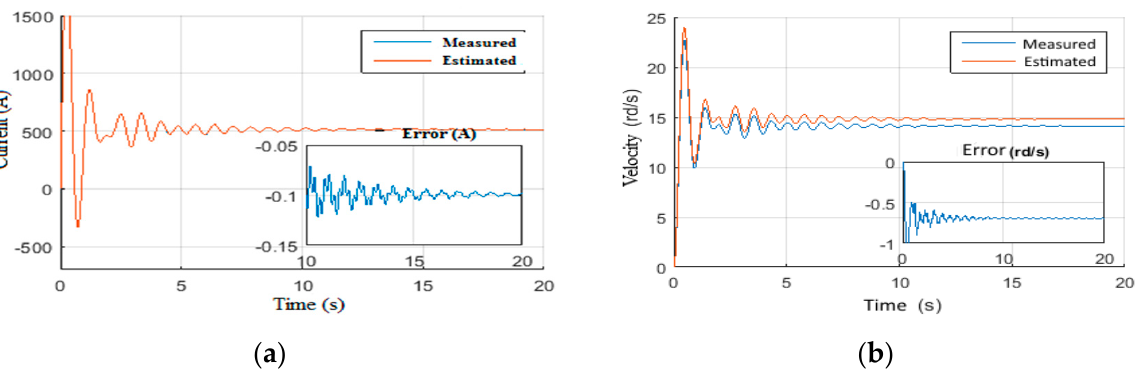
Figure 25. Measured and estimated variables by the designed Observer for Scenario-6: ( a ) Top-drive